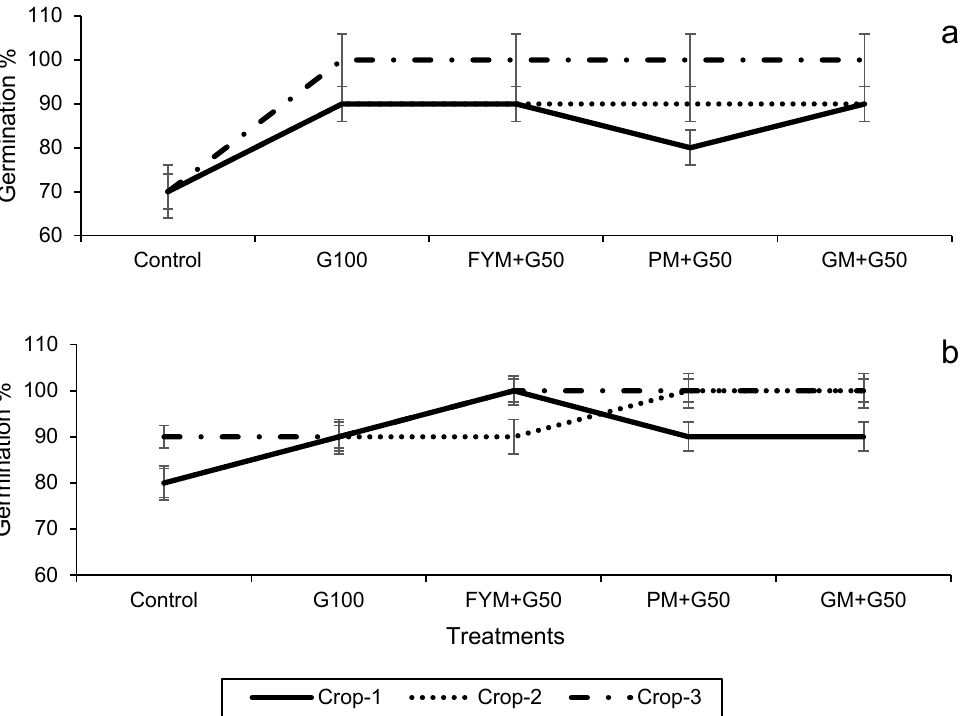
Figure 3. Impacts of different treatments on seed germination of ( a ) wheat and ( b ) maize. Error bars represent the standard error ( n = 3). Different letters indicate statistical difference (LSD, p < 0.05).